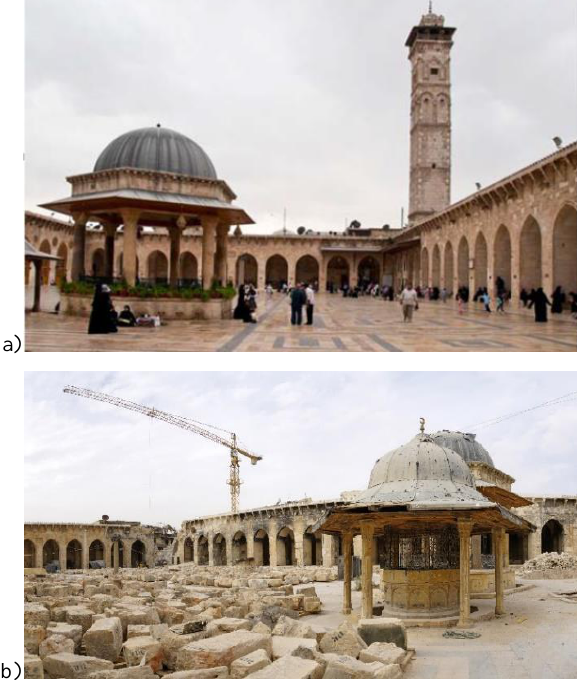
Figure 13. The Minaret of the Great Umayyad Mosque before the war and after the war. The blocks placed on the floor of the court, are numbered, raised with the visible crane and then photographed to proceed with the identification.